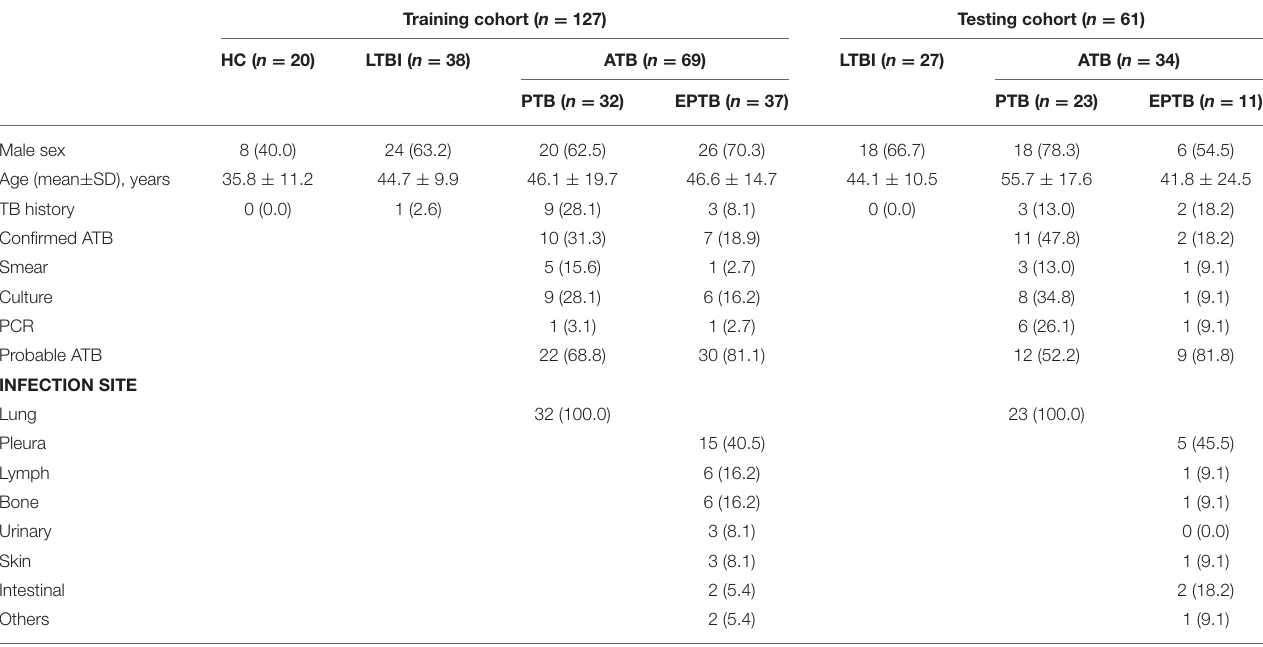
TABLE 1 | Clinical and epidemiological characteristics of the study